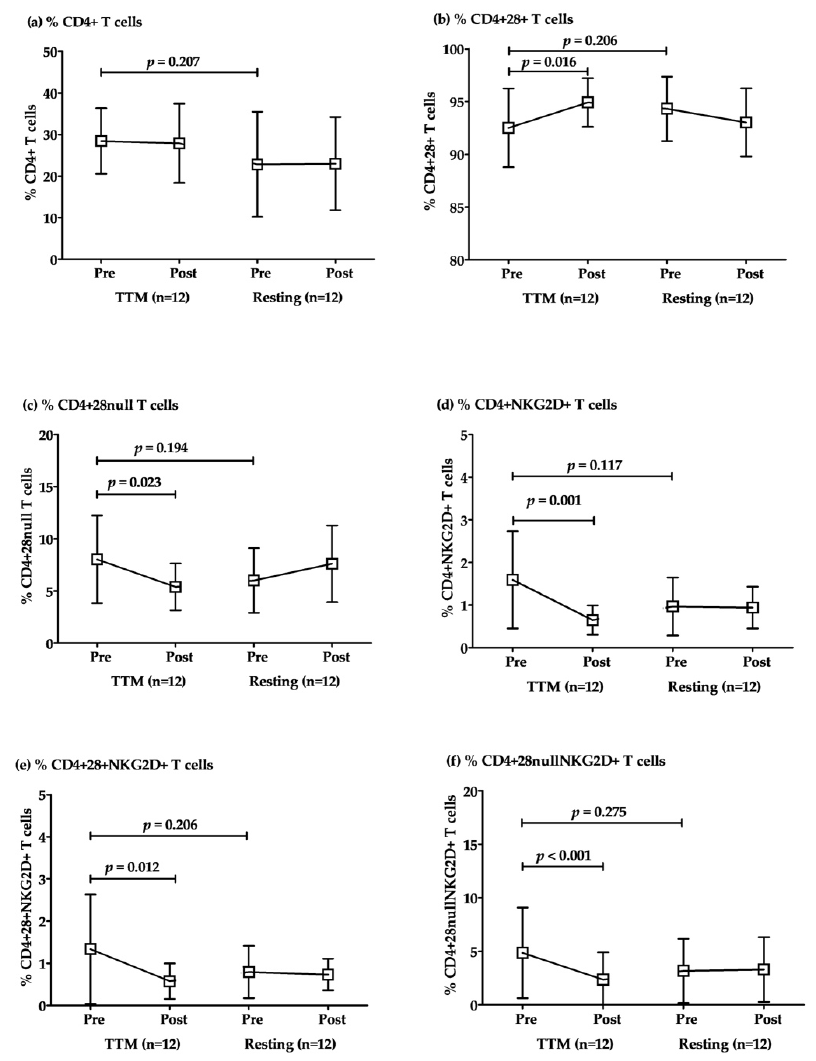
Figure 2. The alteration of CD4+ T cell subsets after multiple rounds of TTM. The representative plotted line graph displays the comparison of the percentages of CD4+ T ( a ), CD4+CD28+ T ( b ), CD4+CD28 null T ( c ), CD4+NKG2D+ T ( d ), CD4+CD28+NKG2D+ T ( e ), and CD4+CD28 null NKG2D+ T cells ( f ) after TTM and resting. Data are displayed as mean ± SD. Statistical analysis was conducted by a two-way repeated-measures ANOVA with Bonferroni’s post hoc test, and significant differences were determined at p < 0.05.